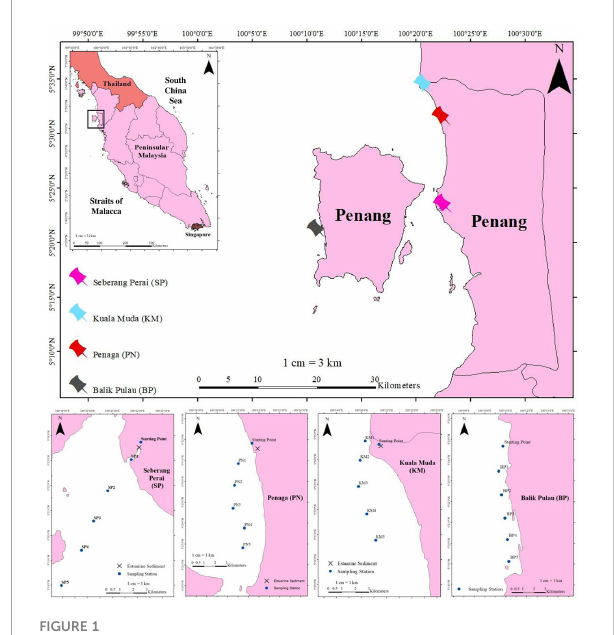
FIGURE 1 Location of Penang at Peninsular Malaysia, and study sites and sampling stations at the estuarine environment of Penang Seberang Perai, Penaga, Kuala Muda, and Balik Pulau